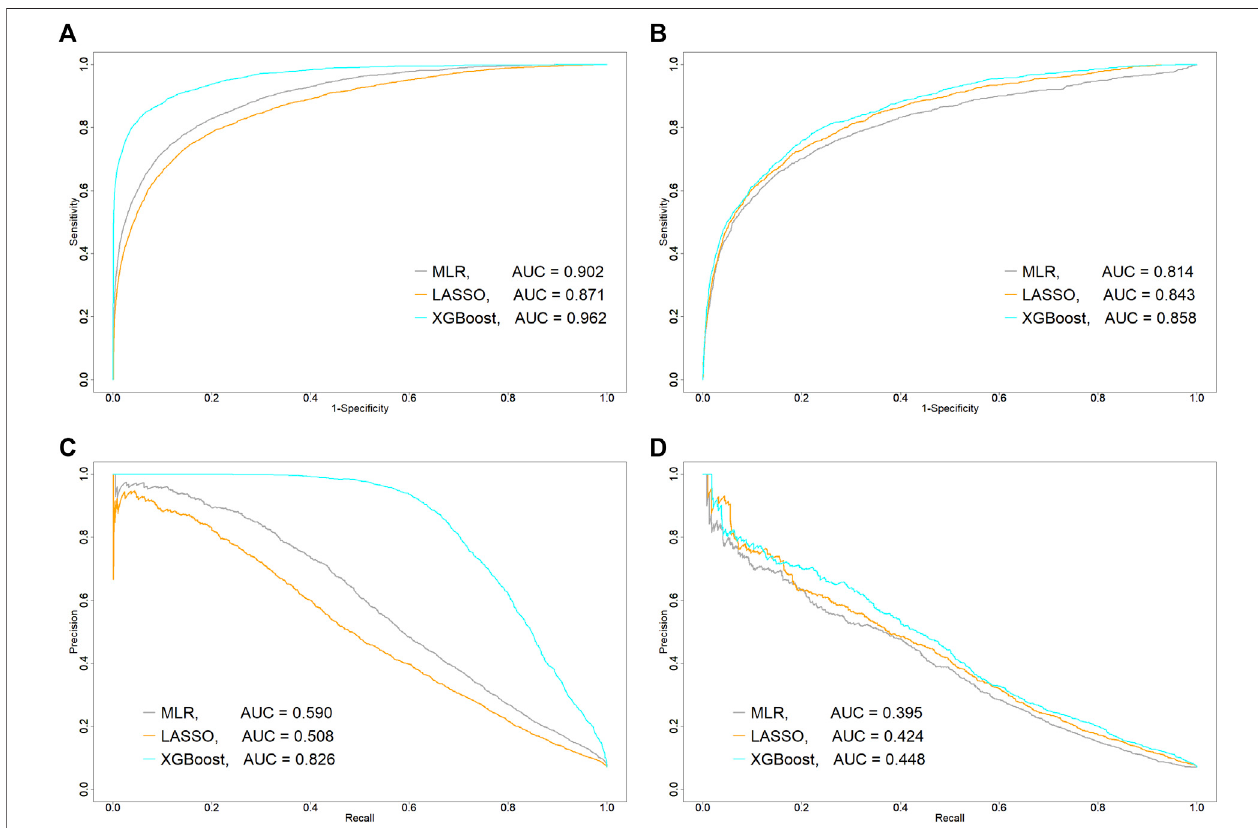
FIGURE 1 | Comparison of predictive performance of each machine-learning algorithm between training and testing sets. (A) Area under receiver operating characteristic curve (AUROC, C statistic) in training set and (B) testing set. (C) Area under precision-recall curve (AUPR) in training set and (D) testing set. AUC, area under the curve; LASSO, least absolute shrinkage and selection operator; MLR, multiple logistic regression; ROC, receiver operating characteristic curve; XGBoost, extreme gradient boosting.